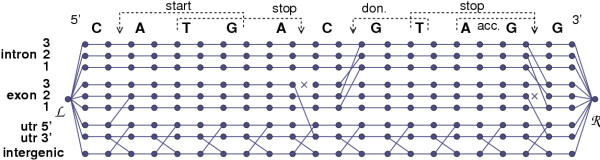
EuGène's directed acyclic graph for a short example sequence. For simplicity purposes, only the forward strand is considered. The DNA sequence is shown above the graph. Horizontal tracks represent the different possible annotations: intergenic (bottom), UTR 5' and 3', exon in the 3 frames, intron in 3 phases (the phase of an intron is defined according to the splicing position in the last codon of the previous exon). On each track, 2 vertices are used to represent each nucleotide. These 2 vertices are linked horizontally by a contents and a transition edge (see the text and Figure 4 for details). Dotted arrows show occurrences of biological signals (like start/stop codons and donor/acceptor splice sites). They produce additional transition edges at the corresponding position. Since this version of EuGÈNE does not include any promoter or polyA site prediction tool, transitions from intergenic to UTR and vice-versa are allowed at every nucleotide position. All consistent gene structures can be represented by a path connecting the initial and terminal vertices  and .